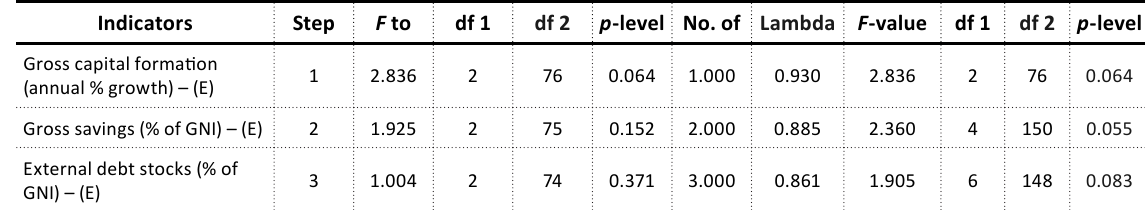
Table 2. Results of stepwise discriminant